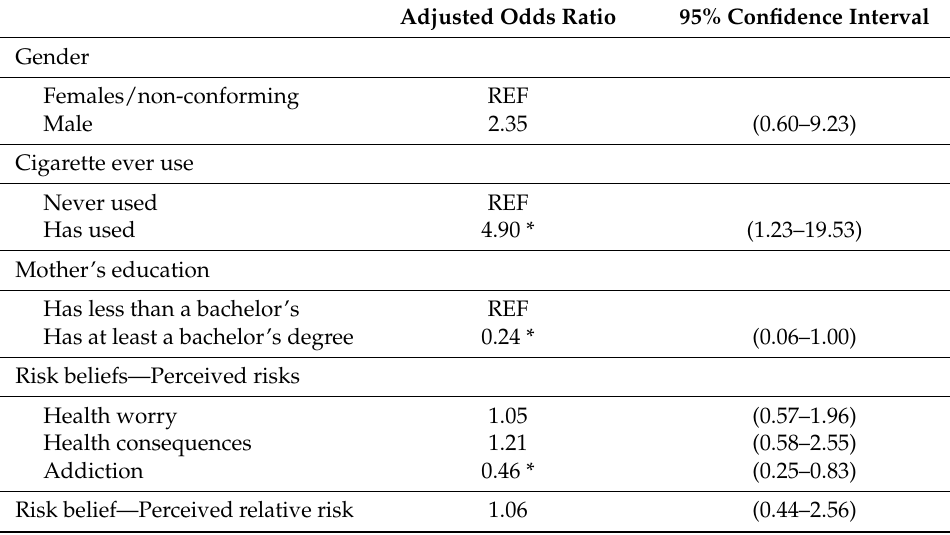
Table 3. Logistic regression predicting ever use of e-cigarettes, N = 68